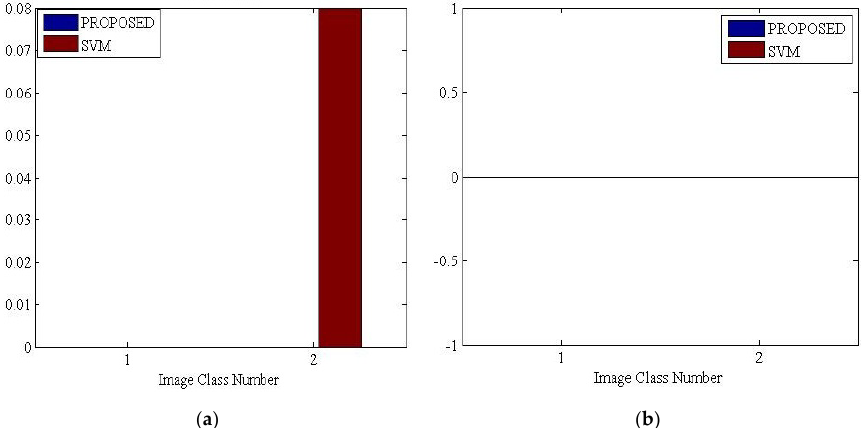
Figure 10. FRR analysis for: ( a ) Indian Pines and ( b ) Pavia University.